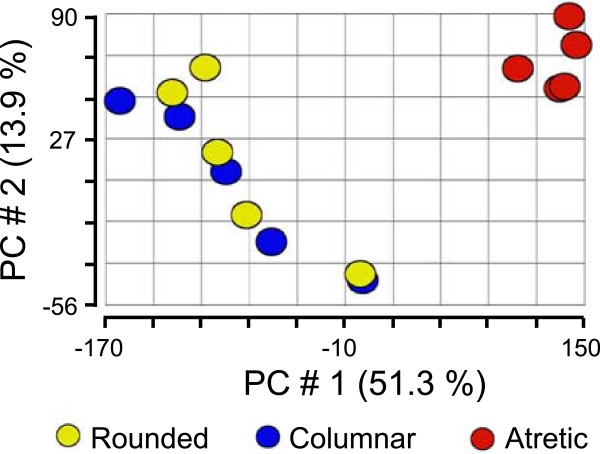
Unsupervised PCA of arrays for small healthy (n = 5 rounded phenotypes in yellow and n = 5 columnar phenotypes in blue) and small atretic (n = 5, in red) follicles. The graph is a scatter plot of the values for the first (X) and second (Y) principal components based on the correlation matrix of the total normalised array intensity data.